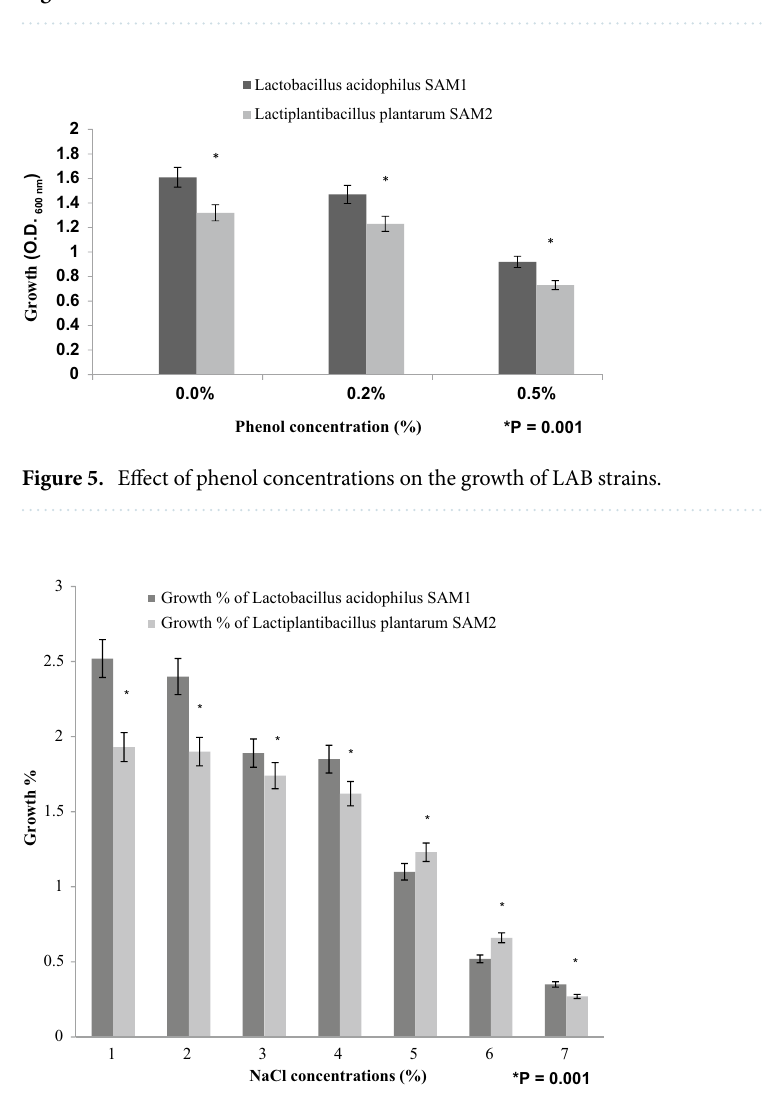
Figure 4. Bile salt tolerance of the LAB strains.